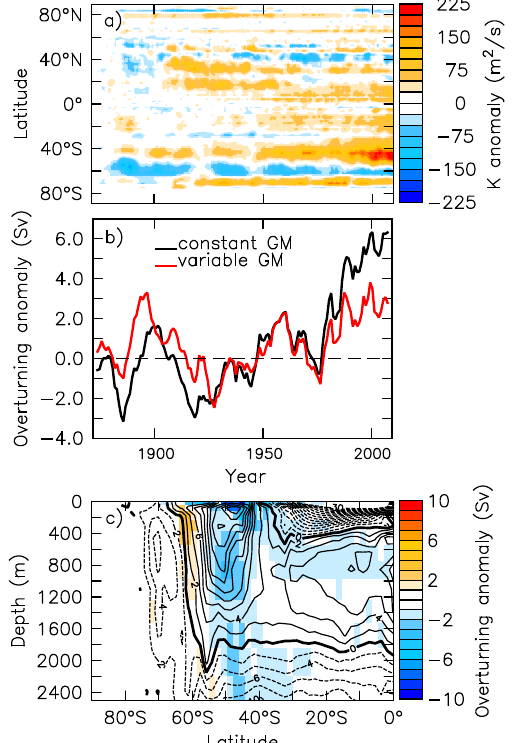
Figure 5. (a) The zonal mean anomaly of eddy diffusivity due to the effect of time-evolving winds in the variable GM experiment (tran- sient minus fixed); (b) wind-induced changes in the Southern Ocean residual overturning circulation and (c) in shading the difference in the residual overturning stream function between the variable and constant GM experiments with transient winds, averaged over 2000 to 2010, with contours giving the overturning stream function in the constant GM experiment over the same